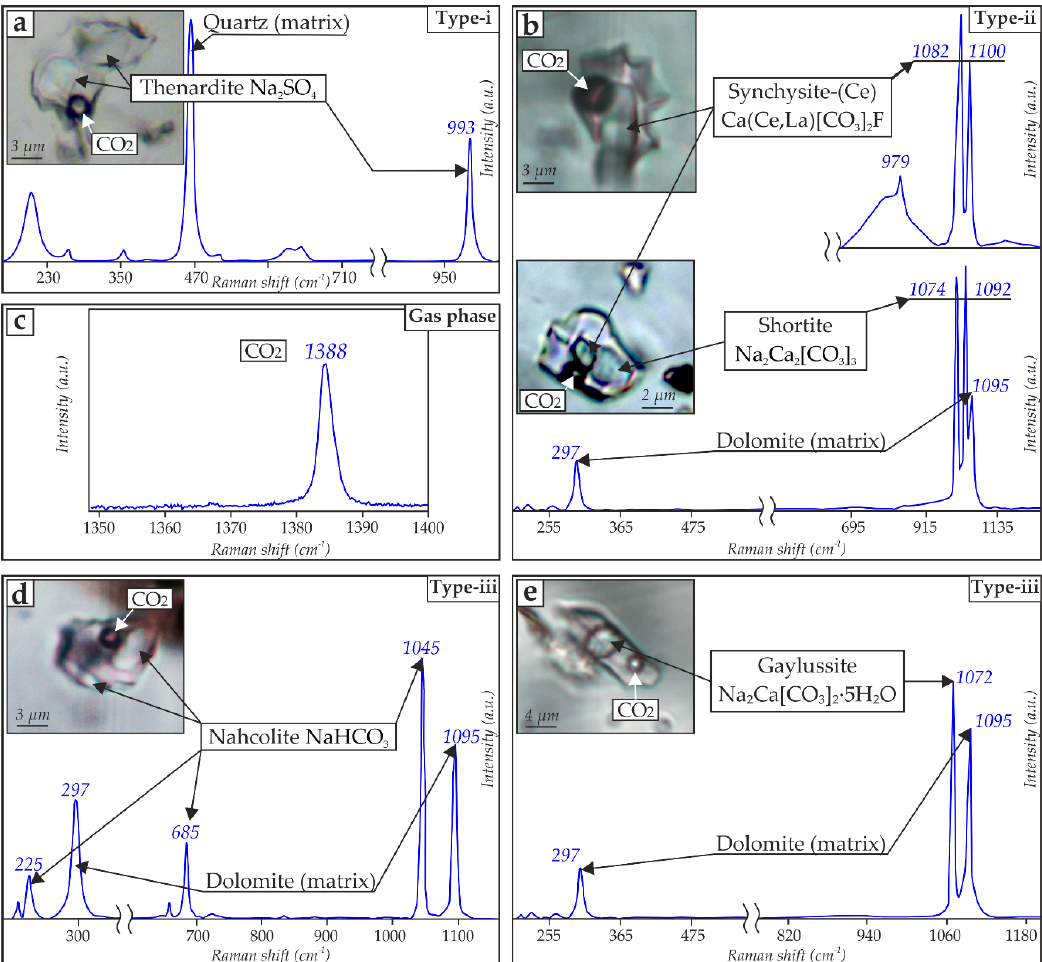
Figure 5. Raman data of the fluid inclusion investigations of the ore-related REE late-stage hydrothermal mineralization of Petyayan-Vara magnesiocarbonatites. ( a ) Photomicrographs and the spectra of thenardite daughter phases in type-i fluid inclusions in quartz; ( b ) photomicrographs of the type-ii fluid inclusions with the spectra of synchysite-(Ce) and shortite daughter phases in the dolomitic matrix; ( c ) the spectrum of the CO 2 gaseous phase of the fluid inclusions; photomicrographs of the type-iii fluid inclusions and the spectra of crystal daughter phases of ( d ) nahcolite and ( e ) gaylussite in the dolomitic matrix.